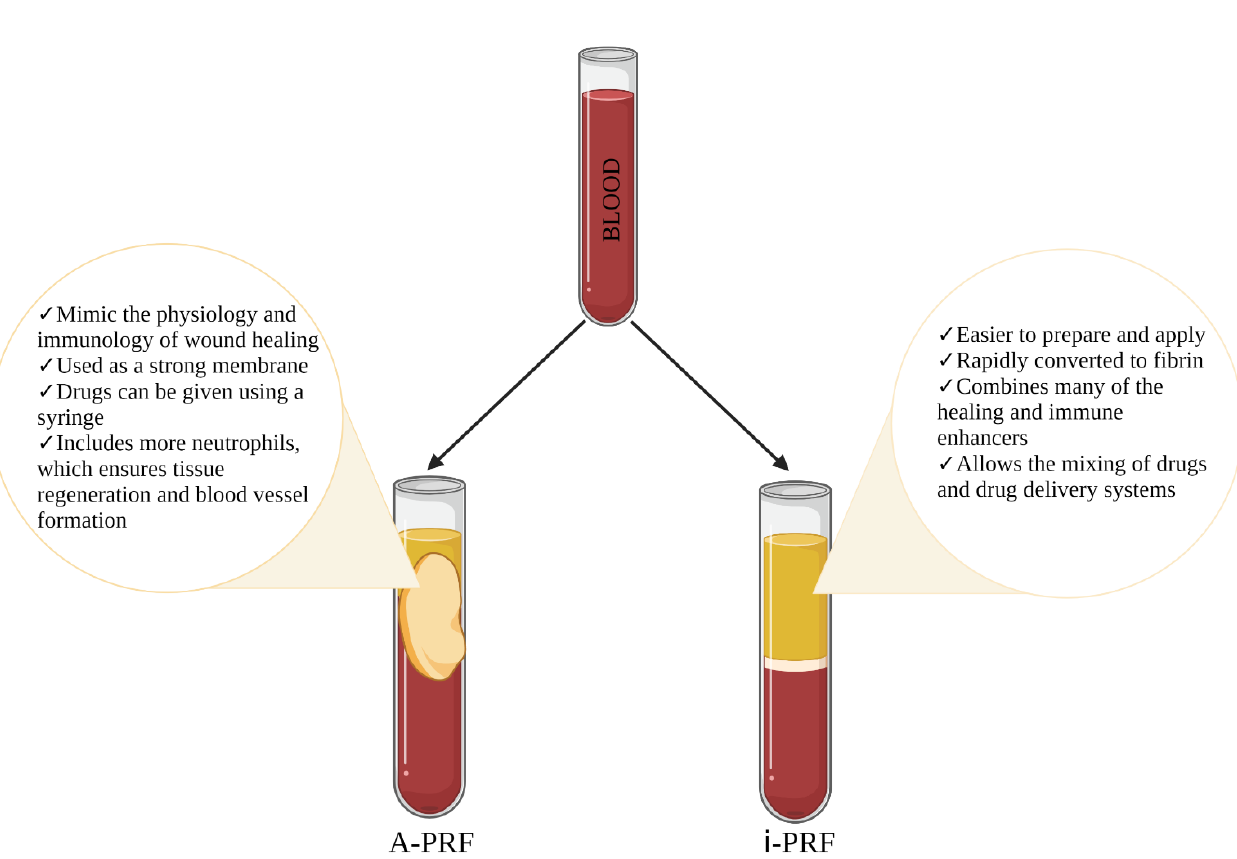
Figure 2. Comparison of the advantages for two concentrates i-PRF and A-PRF. Figure created with Biorender.com.